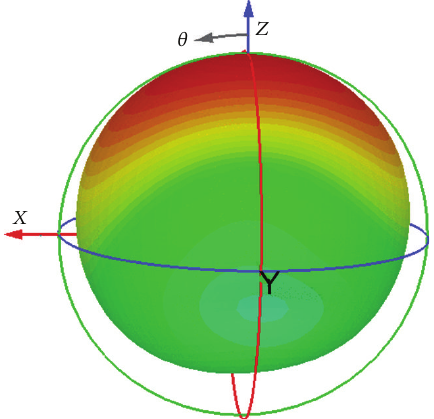
Figure 7: Simulated 3D far-field of the proposed PLPDA antenna at 35